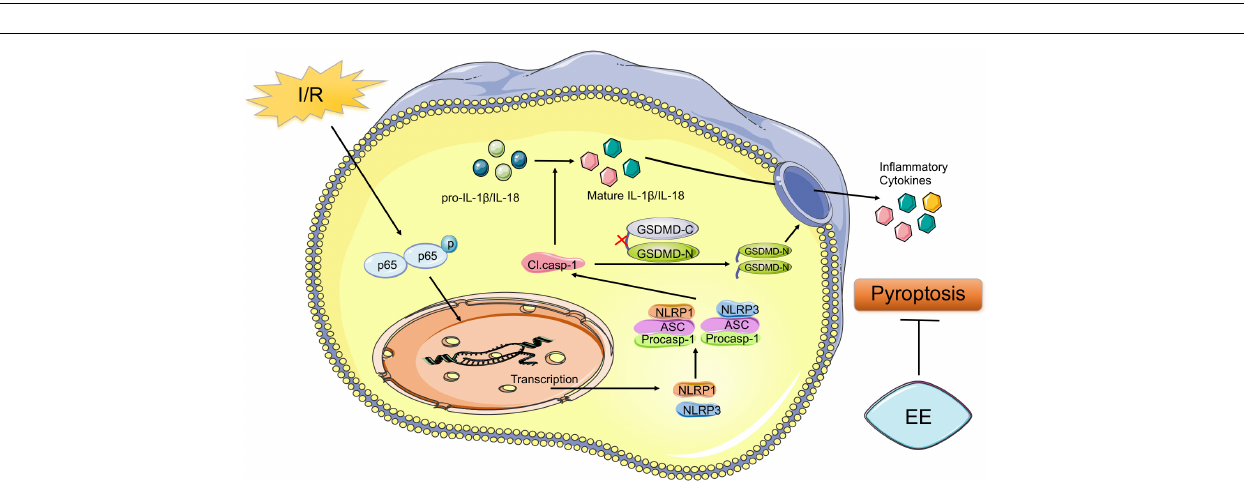
FIGURE 6 | Enriched environment inhibited p65 phosphorylation after I/R injury. (A–C) Western blots and quantification illustrating increases in the activation of NF- κ B (p-p65) in the penumbra. (D) Representative IHC staining images for p-p65 in the penumbra. Scale bars, 50 µ m. (E) IHC score of p-p65 in penumbra. n = 6. Data are expressed as mean ± SD. ** p < 0.01, *** p < 0.001 vs. SSC group; # p < 0.05, ## p < 0.01, ### p < 0.001 vs. ISC group.